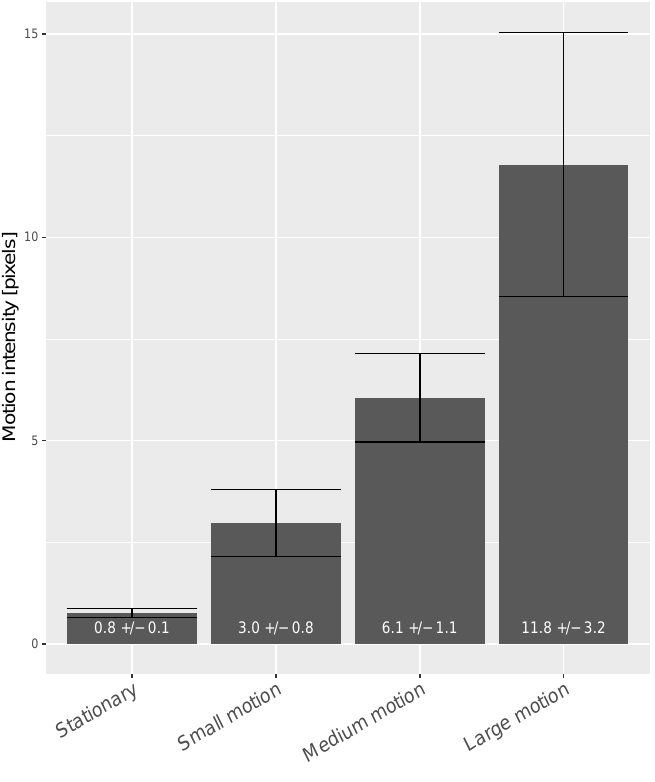
Figure 8. Statistical overview (mean and 95% confidence interval) of HR-band motion intensities of 17 test subjects, categorized in terms of stationary, small motion, medium motion, and large